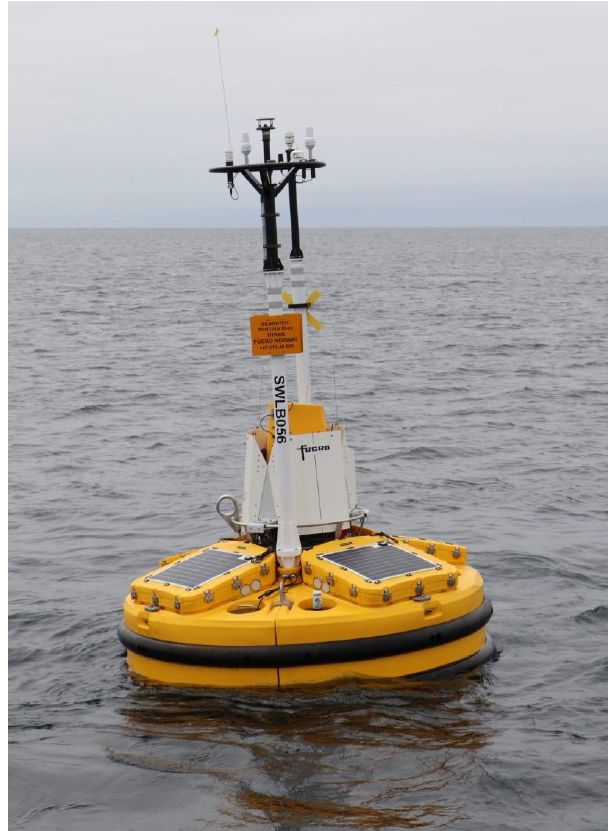
Figure 1. Fugro SEAWATCH Wind LiDAR